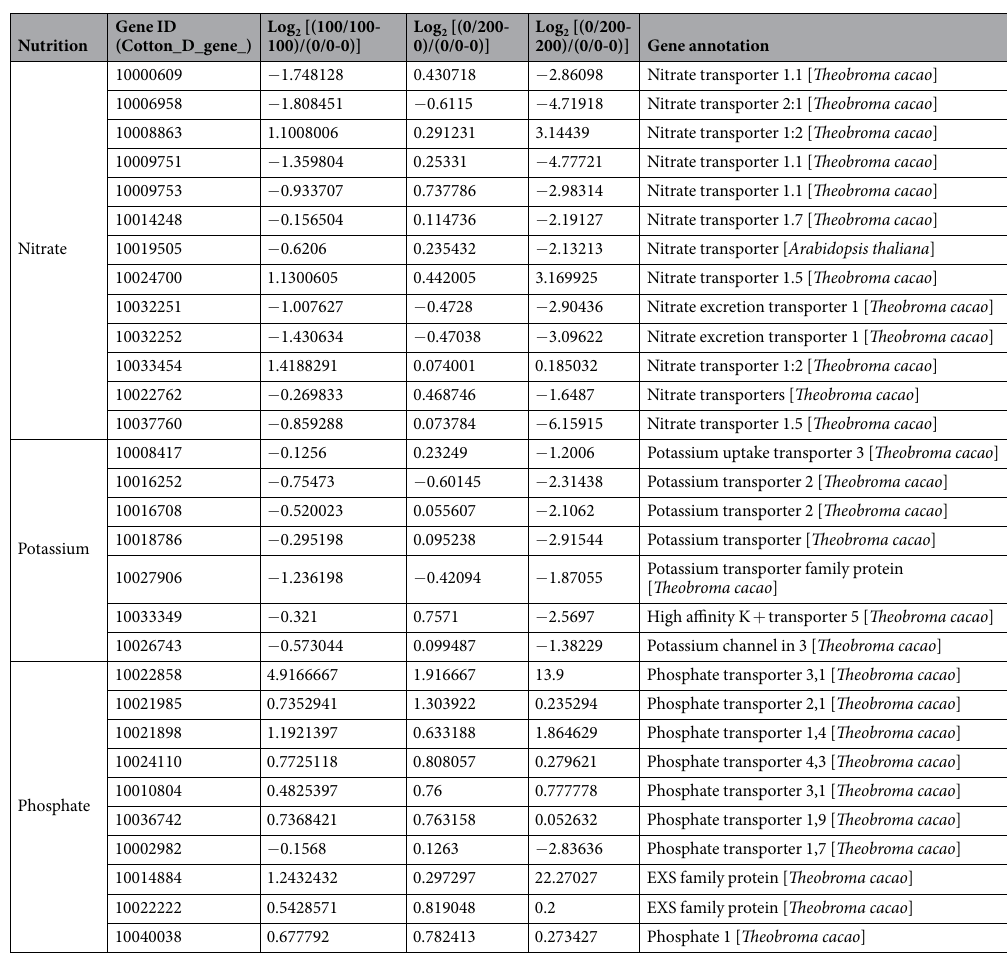
Table 2. The expression pattern of nitrate, potassium and phosphate transport genes in roots under uniform- and non-uniform salinity